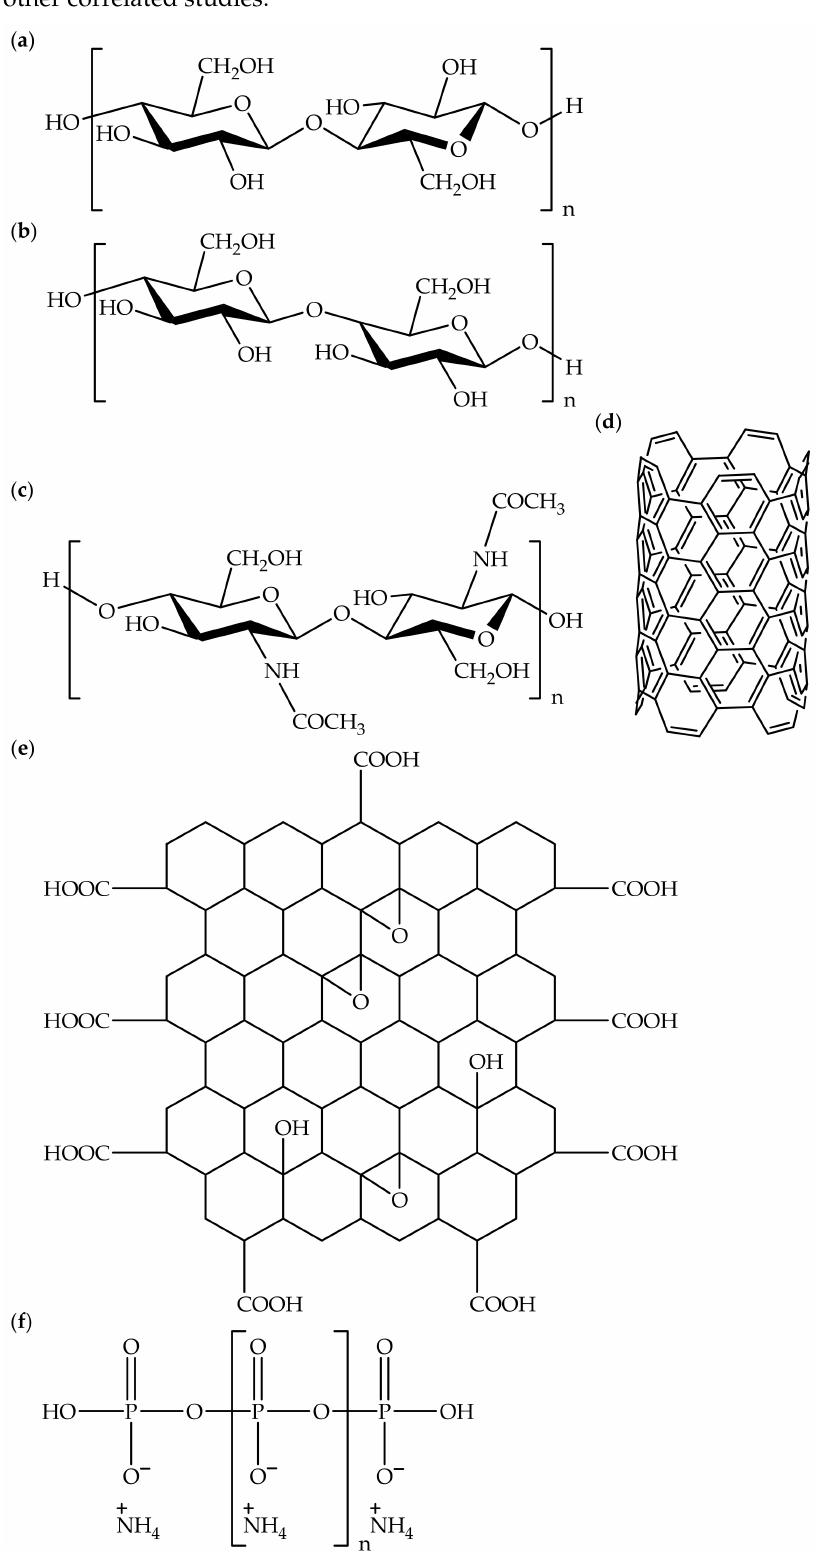
Figure 1. Chemical structures of ( a ) cellulose, ( b ) starch, ( c ) chitin, ( d ) multiwalled carbon nanotubes, ( e ) graphene oxide, and ( f ) ammonium